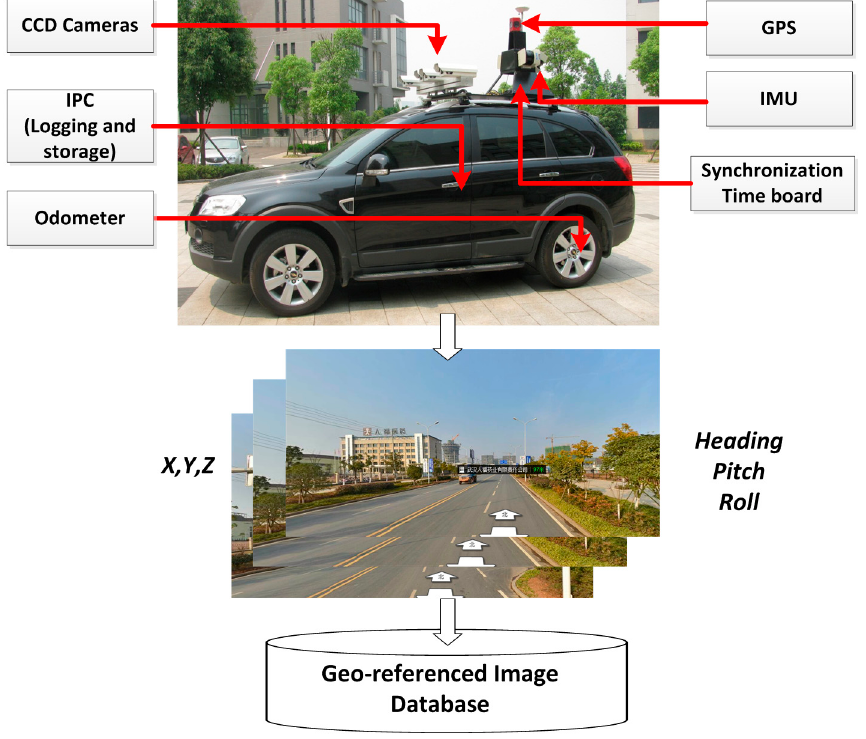
Figure 2. L-MMS for the data collection of geo-referenced database.